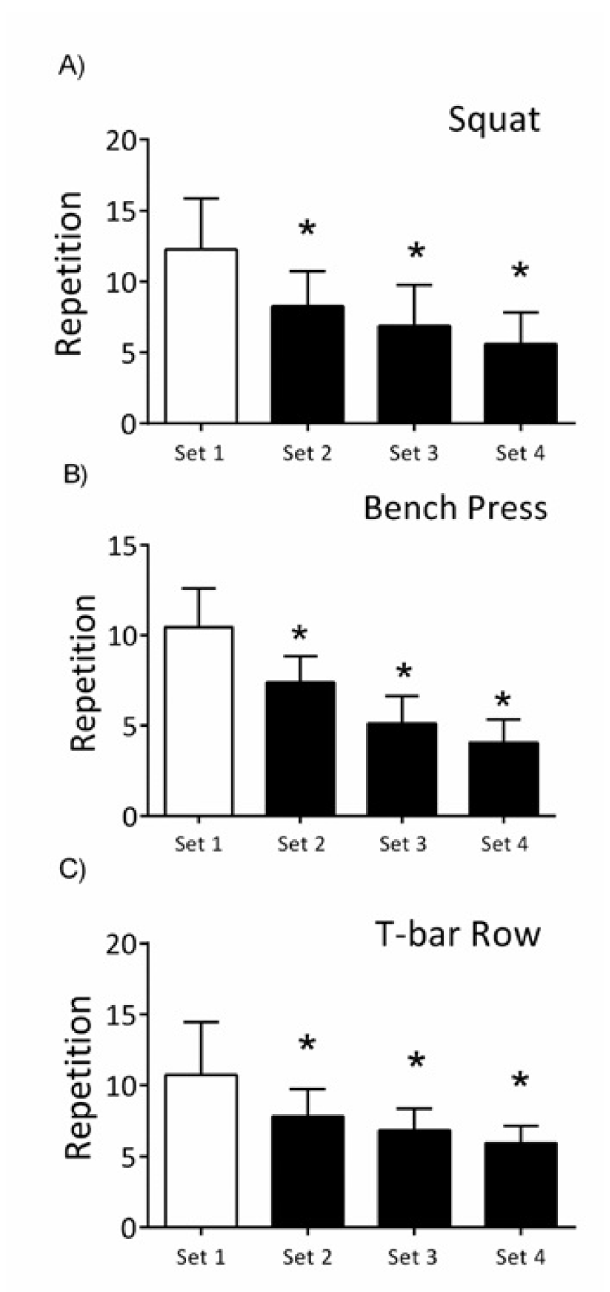
Figure 1 - Number of repetitions of the exercises performed in the acute session of strength training by the 15 participants. (70% of 1RM). Data expressed as mean ± SD values. Statistical analysis was performed using one-way ANOVA followed by the Tukey test. Value of * p <0.05, between 1st, 2nd, 3rd, and 4th